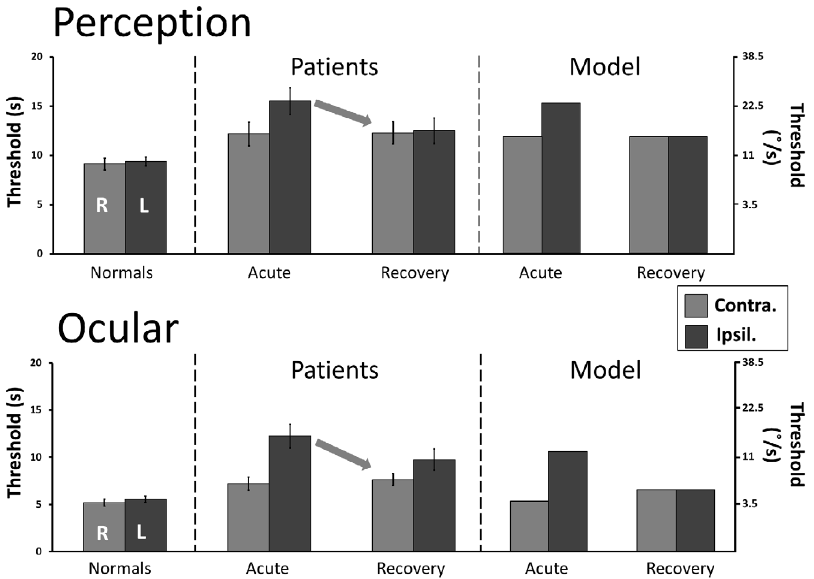
Figure 3. VO and VP thresholds for patients and simulated model data. Mean perceptual (top) and vestibulo-ocular (bottom) thresholds for patient ( 6 SE) and simulated model data, and normal subjects. Thresholds are symmetrical in healthy subjects and lower for VOR than for perception. After acute unilateral vestibular neuritis, thresholds become asymmetric and bilaterally increased with higher thresholds on the affected (ipsilesional) side. After recovery, thresholds remain elevated, but become symmetric again. Simulated thresholds derived from the model show good agreement with patient data; both VO and VP thresholds are elevated and asymmetrical acutely, with a reduction in asymmetry at recovery.